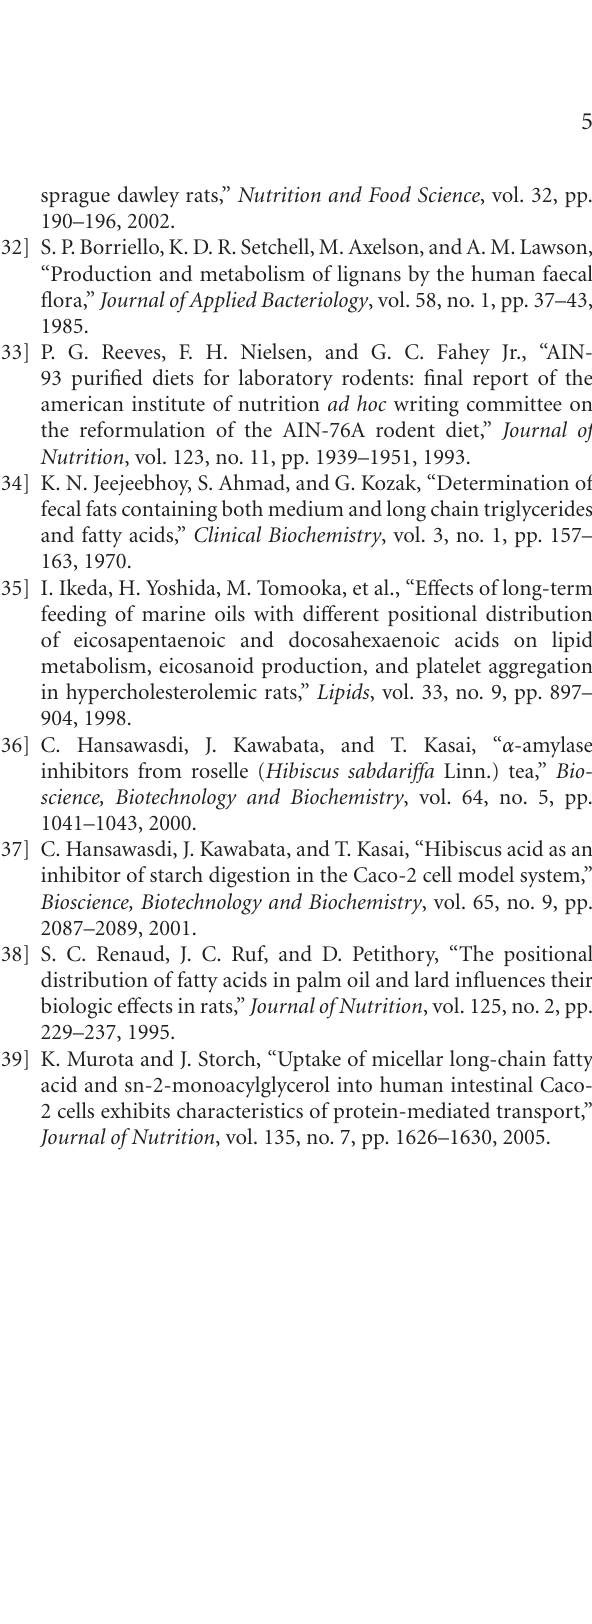
e ff ect of roselle ( Hibiscus sabdari ff a L.) on serum lipid